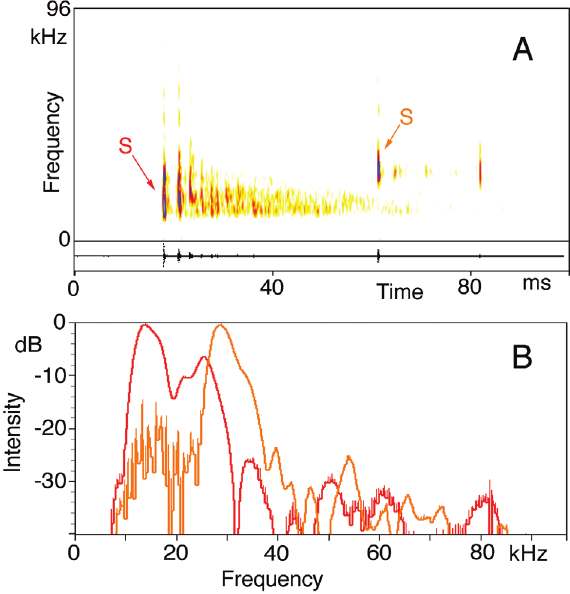
Figure 52. Sonogram of a syllable ( A ) and power spectra of song elements ( B ; see markings in A ) in the calling song of Morgenia lehmannorum sp. n. (different colours mark the dif - ferent sound elements; red: impulse, orange: pulse-like sound).